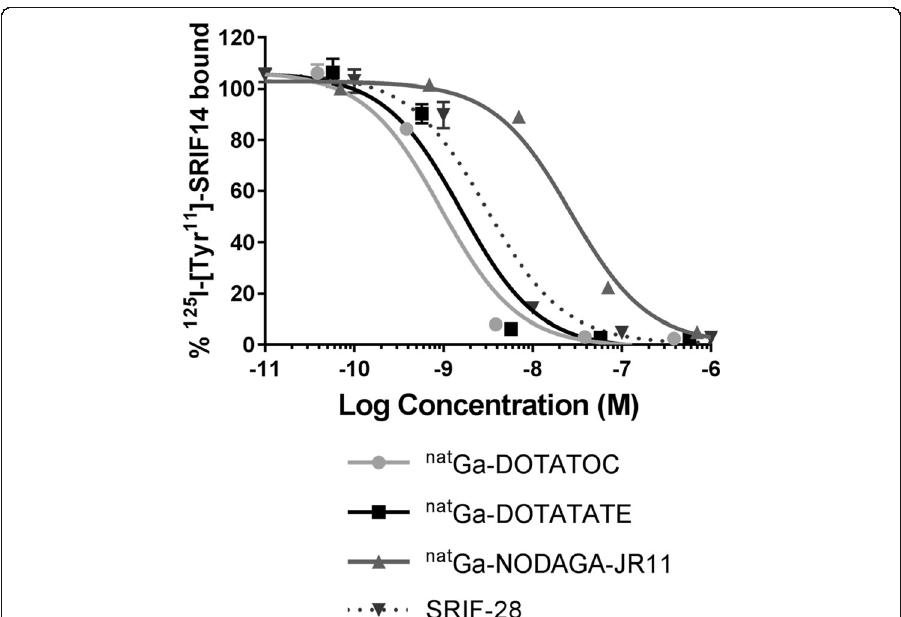
Fig. 1 Representative inhibition curves for nat Ga-DOTATOC, nat Ga-DOTATATE, nat Ga-NODAGA-JR11 and SRIF- 28 against the binding of 125 I-[Tyr 11 ]-SRIF14 to sstr2-overexpressing CHO-K1 membranes